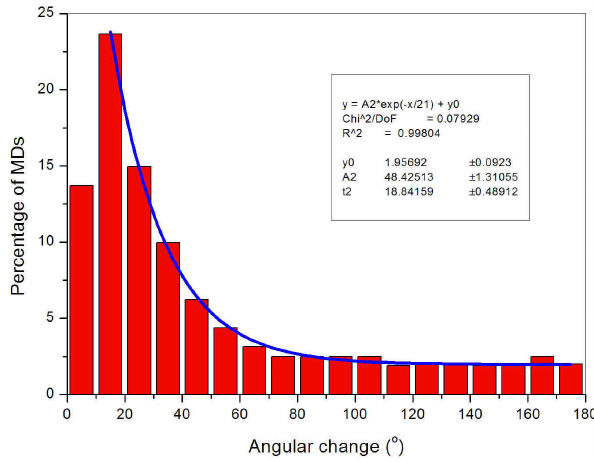
Fig. 9. The magnetic field angular change from one MD to an adja- Figure 9 cent one. All angular changes are